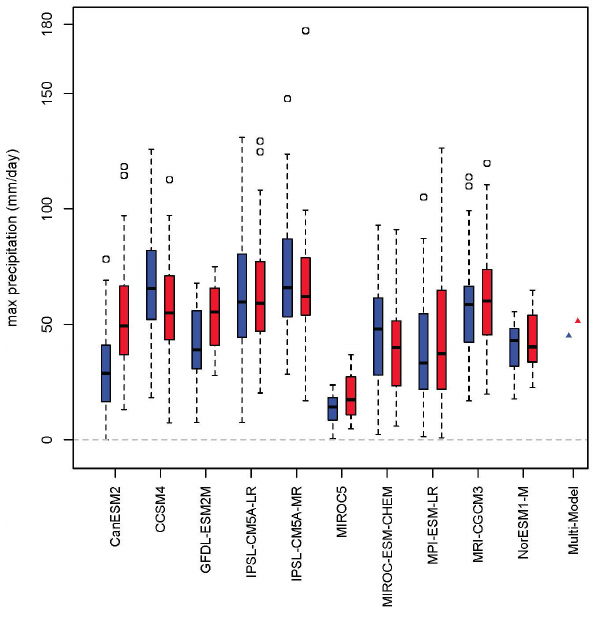
Figure 4. Boxplot summaries of annual maximum AR precipitation (unit:mmday − 1 ) in California from each CMIP5 model, during the 25 years spanning 1981–2005 (blue boxplot) and 2076–2100 under RCP8.5 (red boxplot). Blue and red triangles represent the ensemble mean of AR precipitation extremes for the historical and RCP8.5 runs, respectively.